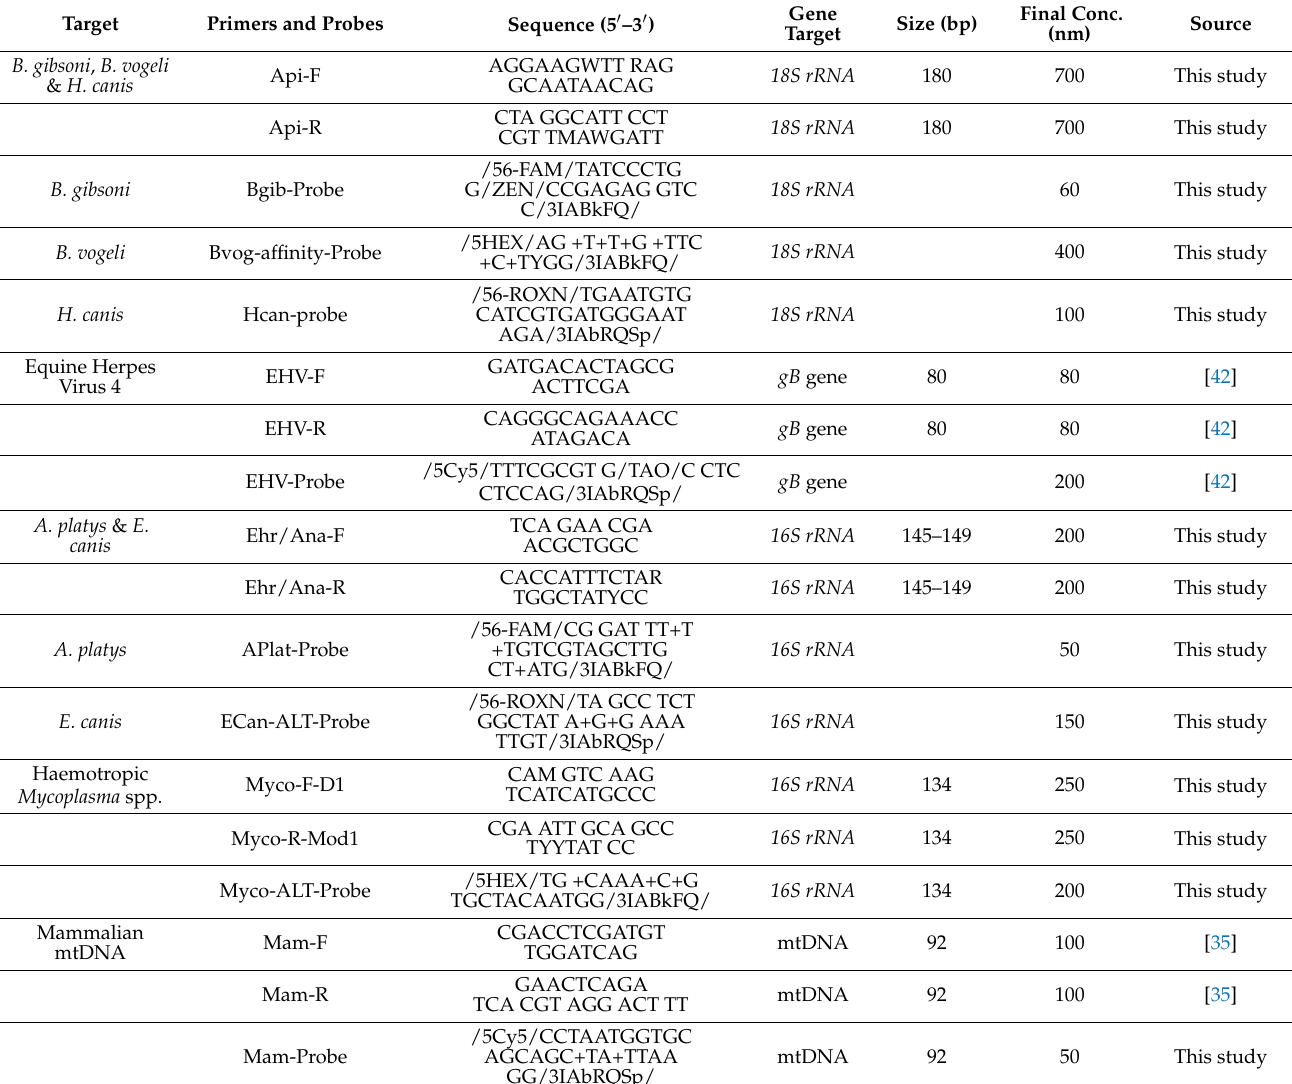
Table 1. Oligonucleotide primers and probes, including fluorophores, for two quadruplex assays for canine VBP detection, with a + denoting a proceeding locked nucleic acid (LNA) base. Final reagent concentrations in reactions are